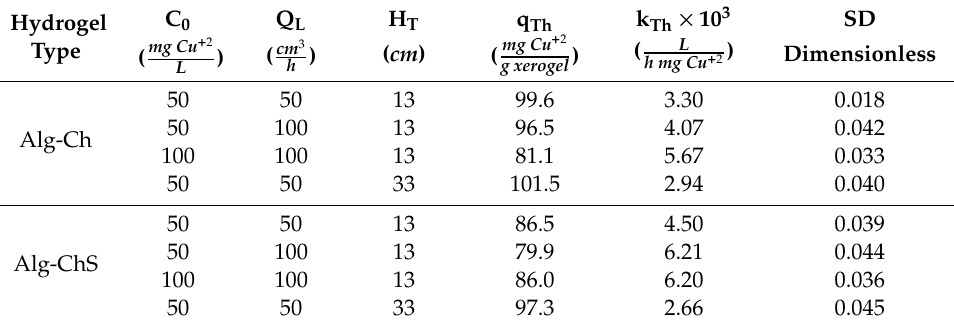
Table 4. Thomas model parameters obtained using nonlinear regression